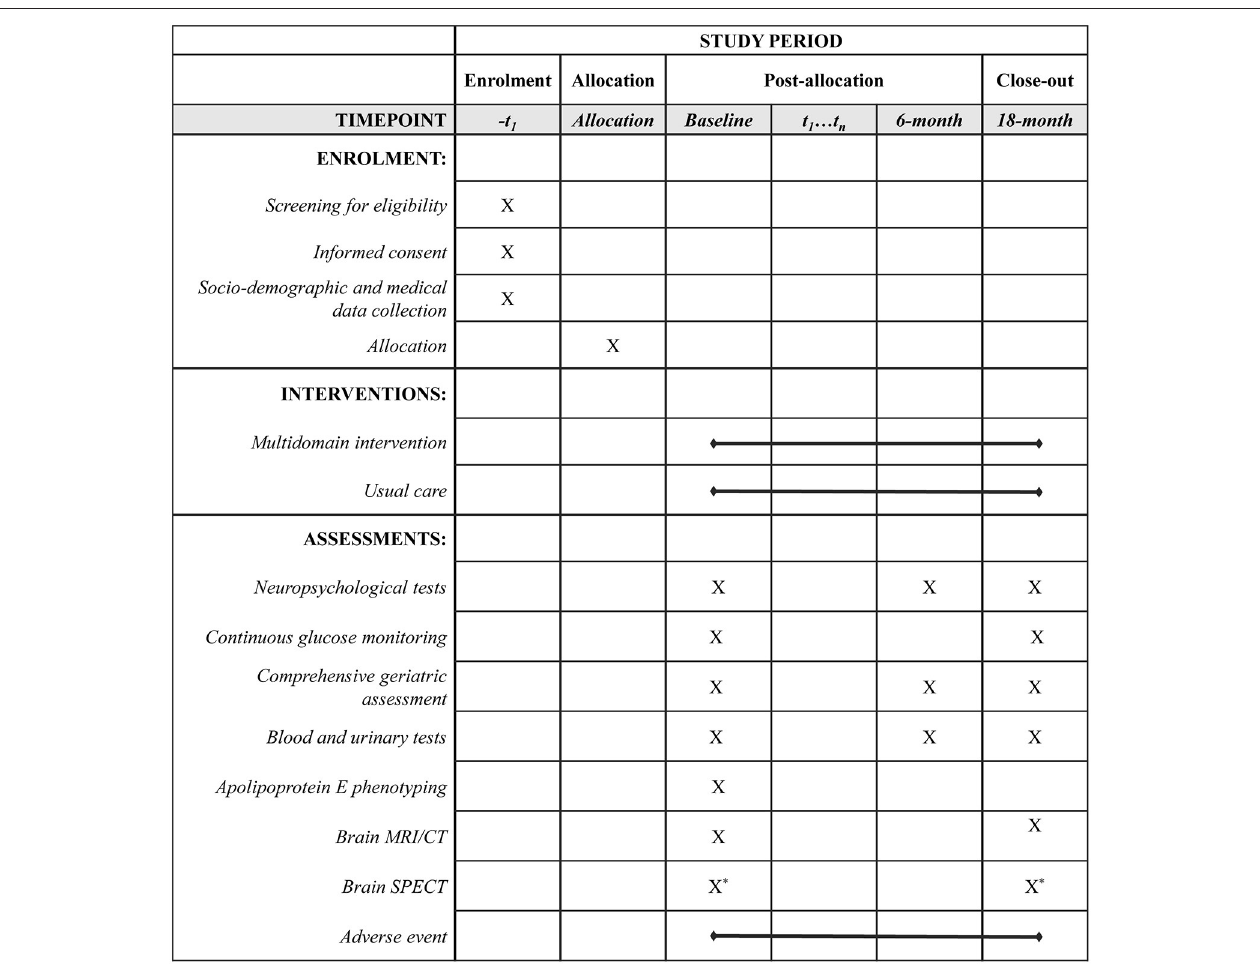
FIGURE 2 | Timeline for participants in the J-MIND-Diabetes trial. *: Non-mandatory, -t 1 : visit within 8-week before the day of allocation, t 1 …t n : visit to the hospital during the study period. CT, computed tomography; J-MIND-Diabetes, japan-multi-domain intervention trial for prevention of dementia in older adults with diabetes; MRI, magnetic resonance imaging; SPECT, single photon emission computed